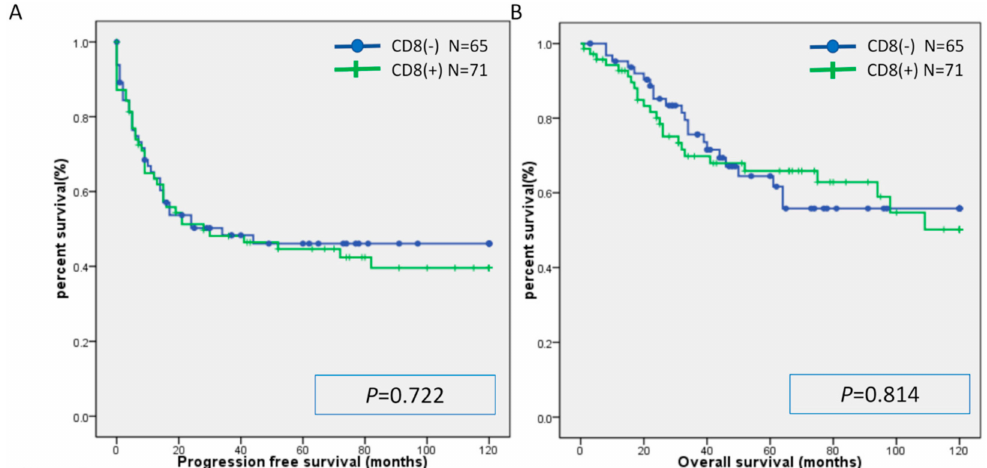
Figure 2. Kaplan-Meier analysis of progression-free survival ( A ) and overall ( B ) survival between the CD8 ( + ) group and CD8(-) group.